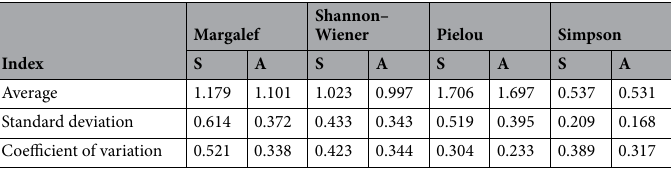
Table 4. Diversity of woody layer inside tiankeng. S showed shrub layer; A showed arbor